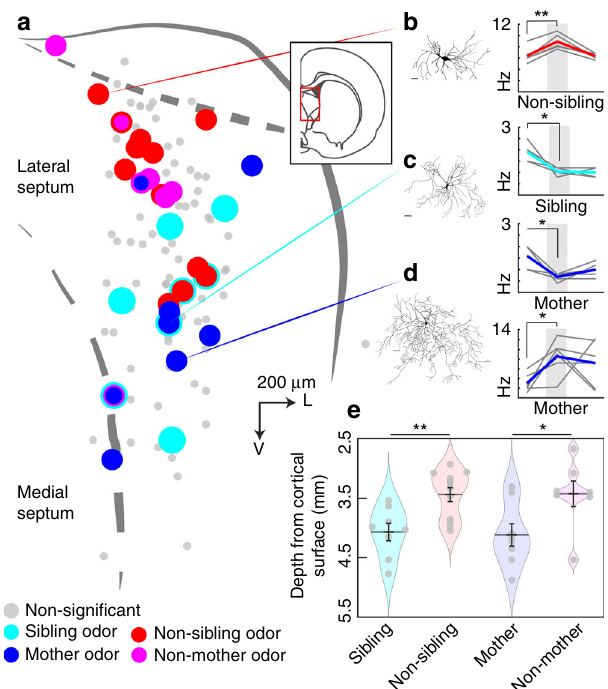
Fig. 8 The lateral septum shows nepotopy — a representation of response preferences ordered according to kinship. a Locations of recorded neurons from P16 + age group with signi fi cant responses to kin- and non-kin stimuli color coded. See “ Methods ” for details on how this composite map of cells was plotted. V ventral, L lateral, scale bar = 200 µ m. b Left, morphological reconstruction of dorsal lateral septal neuron responding to non-sibling odors. Right, fi ring rates in baseline (left), during odor presentation (middle) and the offset period (right) for non-sibling odor ( n = 5 trials; baseline mean ± s.e.m. = 6.40 ± 0.68 Hz; odor mean 8.92 ± 0.63 Hz; difference = 2.52 ± 0.39 Hz; p = 0.003, paired t -test). c Left, morphological reconstruction of lateral septum neuron signi fi cantly inhibited by mother and sibling odors. Sibling odor ( n = 5 trials; baseline mean ± s.e.m. = 1.90 ± 0.19 Hz; odor mean 1.04 ± 0.08 Hz, difference = 0.86 Hz; p = 0.024, paired t -test). Mother odor (n = 5 trials; baseline mean 1.60 ± 0.25 Hz; odor mean 0.68 ± 0.08 Hz; difference = 0.92 ± 0.27 Hz; p = 0.026, paired t -test). d Left, morphological reconstruction of a lateral septum neuron responding signi fi cantly to mother odor ( n = 6 trials; baseline mean 3.00 ± 0.76 Hz; odor mean 8.57 ± 1.48 Hz; difference = 5.57 ± 1.62 Hz; p = 0.019, paired t -test). e Depths of signi fi cantly responsive cells. Sibling odor responsive cells ( n = 8; mean depth ± s.e.m. = 4068 ± 148 µ m). Non-sibling odor responsive ( n = 12; mean depth ± s.e.m. = 3441 µ m ± 115 µ m). Sibling vs. non-sibling depth comparison (difference = 627.125 µ m; p = 0.003, t -test). Mother odor responsive neurons ( n = 8; mean depth ± s.e.m. = 4117 ± 532 µ m). Non-mother odor responsive cells ( n = 7; mean depth ± s.e.m. = 3429 ± 567 µ m). Mother vs. non-mother depth comparison (difference = 688.036 µ m; p = 0.031, t -test). Thick black horizontal lines represent means, error bars are s.e.m. Thick colored lines represent the mean of fi ring rates and gray lines in the background represent individual trials. All tests are two-tailed. Scale bars for reconstructed cells: 25 µ m. For